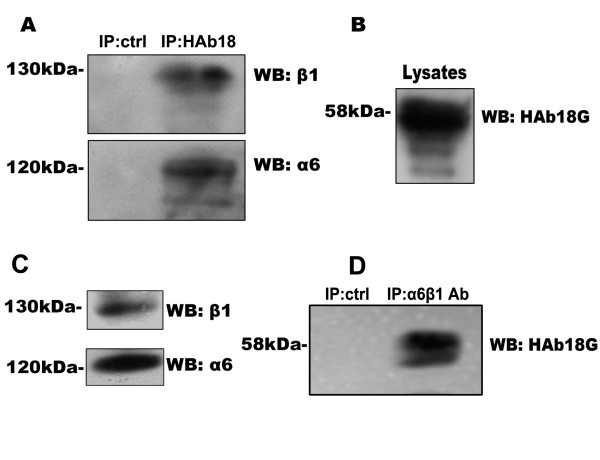
Immunoprecipitation of HAb18G/CD147 and integrin α6 and β1 subunits in FHCC98 cells. (A) Precipitates from HAb18G/CD147 immunocomplexes were assayed for precipitated integrin α6 and β1 subunits. Precipitates from irrelevant antibody (Mouse IgG) were used as a negative control. (B) Expression of HAb18G/CD147 in FHCC98 cell lysates by Western blot. (C) Expression of integrin α6 and β1 subunits in FHCC98 cell lysates by Western blot. (D) Precipitates from α6β1 immunocomplexes were assayed for precipitated HAb18G/CD147. Precipitates from irrelevant antibody (Mouse IgG) were used as a negative control.